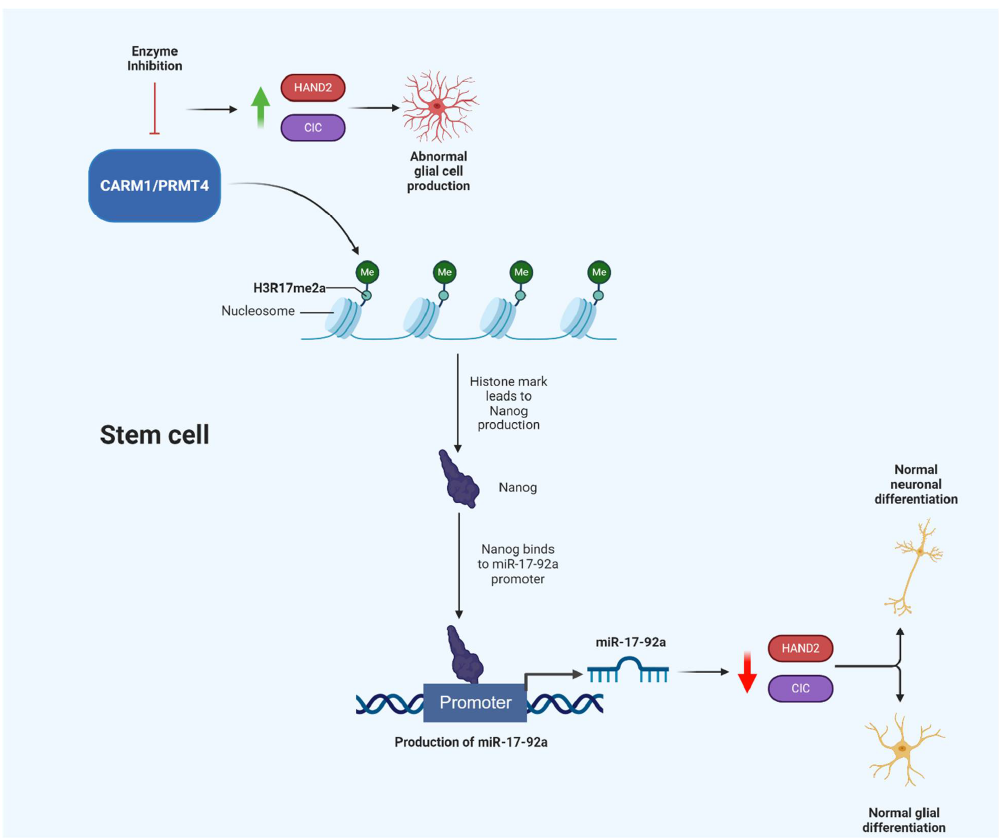
Figure 2. Schematic drawing of the proposed CARM1/PRMT4-miR-17-92a axis. Enzyme inhibition is purported to lead to abnormal glial cell production. CARM1 = Coactivator Associated Arginine Methyltransferase 1; PRMT4 = Protein arginine methyltransferase 4; miR = microRNA. Created with BioRender.com.